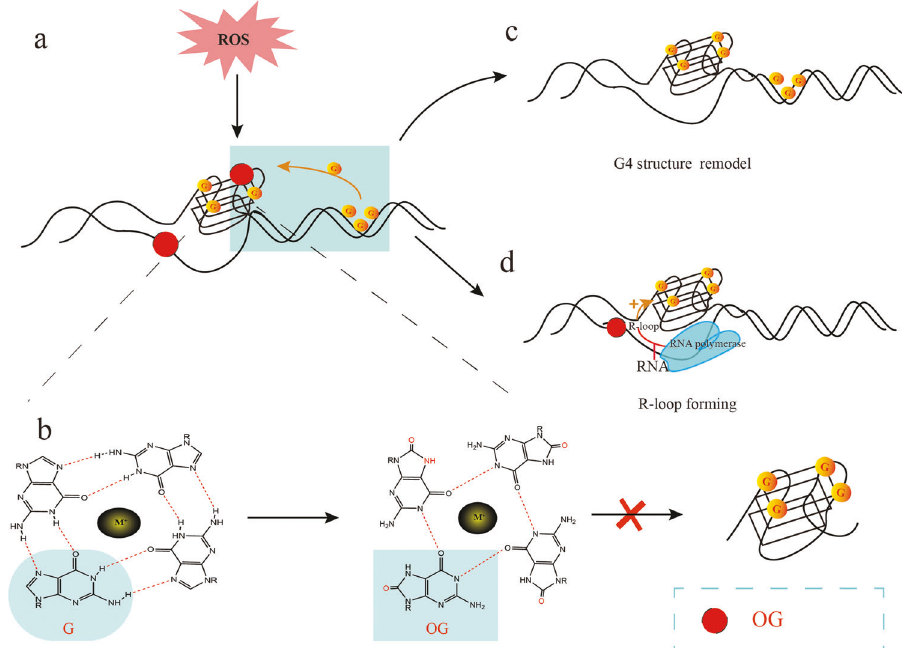
Fig. 3 Role of ROS in G4 formation and stability. ROS oxidizes guanine in G4s and blocks the Hoogsteen hydrogen bonds, which disrupts the thermal stability of the G4 structure ( a , b ). The guanine bases in the surrounding G-rich region can compensate for the missing guanine and stabilize the G4 structure ( a ). In addition, G4 can also be modi fi ed into other structural forms by altering the G4-forming mode ( c ). Oxidation of the guanine base in the DNA template chain can also form OG. With the help of RNA polymerase, the RNA chain can form R-loop with the original DNA chain and stabilize the G4 structure ( d